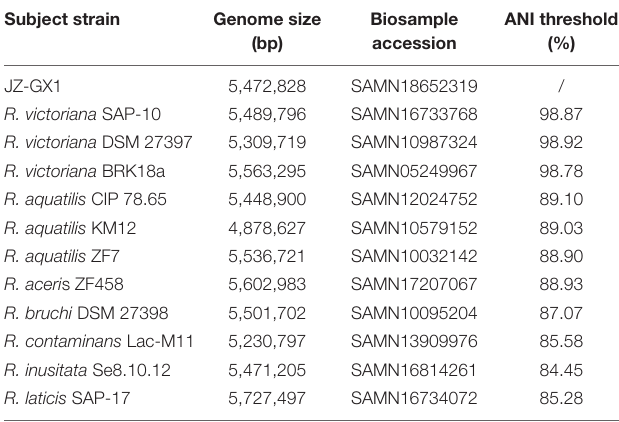
TABLE 1 | Average nucleotide identity (ANI) values based on alignment of the whole genome of strain JZ-GX1 and the most closely related members of the genus Rahnella .